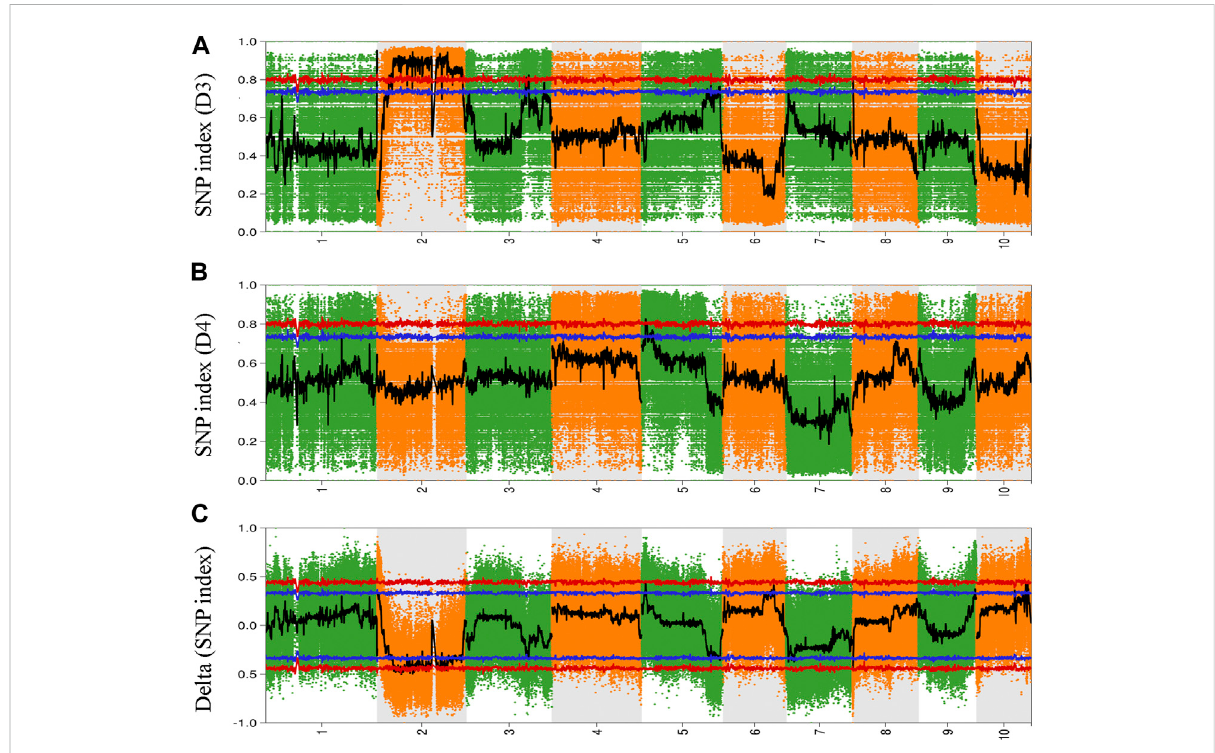
FIGURE 2 Genome-wide distribution of SNP-index in (A) D3 bulk and (B) D4 bulk (C) Delta (SNP-index) between De bulk and D4 bulk. The abscissa is the chromosome name, the colored dots represent the calculated SNP-index (or Δ SNP-index value, and the black line is the fi tted SNP-index or Δ SNP- index value. The red line represents the threshold line with a con fi dence level of 0.99; the blue line represents the threshold line with a con fi dence level of